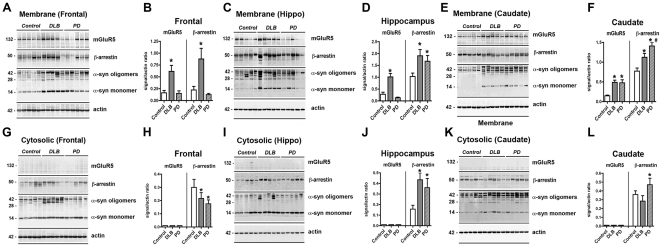
mGluR5, beta-arrestin and alpha-syn expression in frontal cortex, hippocampus and caudate of Control, DLB and PD cases.(A) Representative immunoblot of mGluR5, beta-arrestin and alpha-syn expression levels in the membrane fraction of the frontal cortex from control, DLB and PD cases. (B) Analysis of mGluR5 and beta-arrestin levels in the membrane fraction of the frontal cortex. (C) Representative immunoblot of mGluR5, beta-arrestin and alpha-syn expression levels in the membrane fraction of the hippocampus from control, DLB and PD cases. (D) Analysis of mGluR5 and beta-arrestin levels in the membrane fraction of the hippocampus. (E) Representative immunoblot of mGluR5, beta-arrestin and alpha-syn expression levels in the membrane fraction of the caudate from control, DLB and PD cases. (F) Analysis of mGluR5 and beta-arrestin levels in the membrane fraction of the caudate. (G) Representative immunoblot of mGluR5, beta-arrestin and alpha-syn expression levels in the cytosolic fraction of the frontal cortex from control, DLB and PD cases. (H) Analysis of mGluR5 and beta-arrestin levels in the cytosolic fraction of the frontal cortex. (I) Representative immunoblot of mGluR5, beta-arrestin and alpha-syn expression levels in the cytosolic fraction of the hippocampus from control, DLB and PD cases. (J) Analysis of mGluR5 and beta-arrestin levels in the cytosolic fraction of the hippocampus. (K) Representative immunoblot of mGluR5, beta-arrestin and alpha-syn expression levels in the cytosolic fraction of the caudate from control, DLB and PD cases. (L) Analysis of mGluR5 and beta-arrestin levels in the cytosolic fraction of the caudate. * Indicates a significant difference between DLB or PD cases compared to control cases (p<0.05, one-way ANOVA and post hoc Fisher). # Indicates a significant difference between DLB and PD cases (p<0.05, one-way ANOVA and post hoc Fisher).